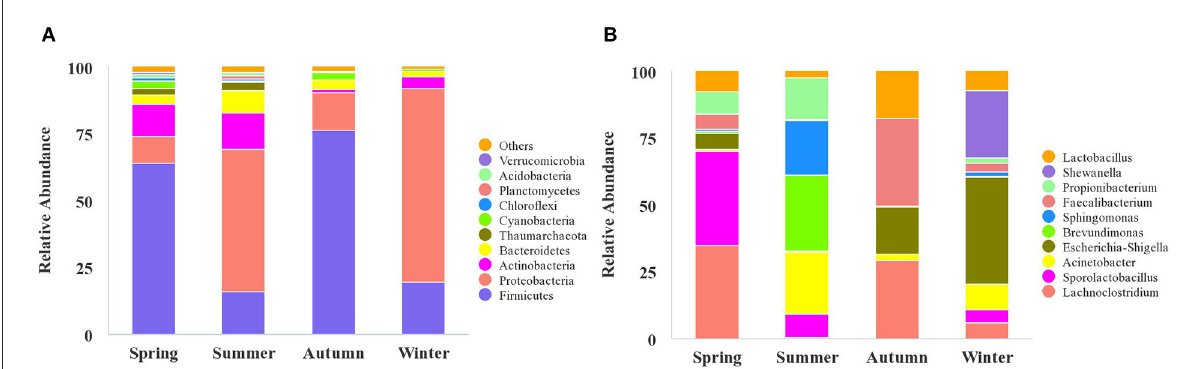
FIGURE3 The microbiota composition in the air of broiler house. The relative abundance of OTUs was used to determine the bacterial composition at phylum (A) and genus (B) levels. In A and B, the abscissa shows the sample names, the ordinate shows the proportions of the species in the samples, the columns of different colors represent different species, and the lengths of the columns represent the proportions of the species. Only the top 10 phyla and genera are displayed, with unidentified and lowly abundant bacteria collectively denoted as “others.”